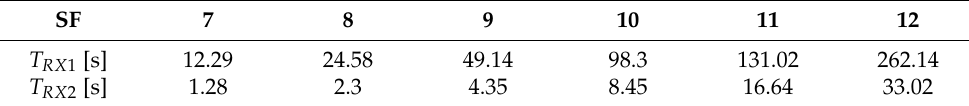
Table 7. RX1 and RX2 duration when no packets are received by the ED [26].